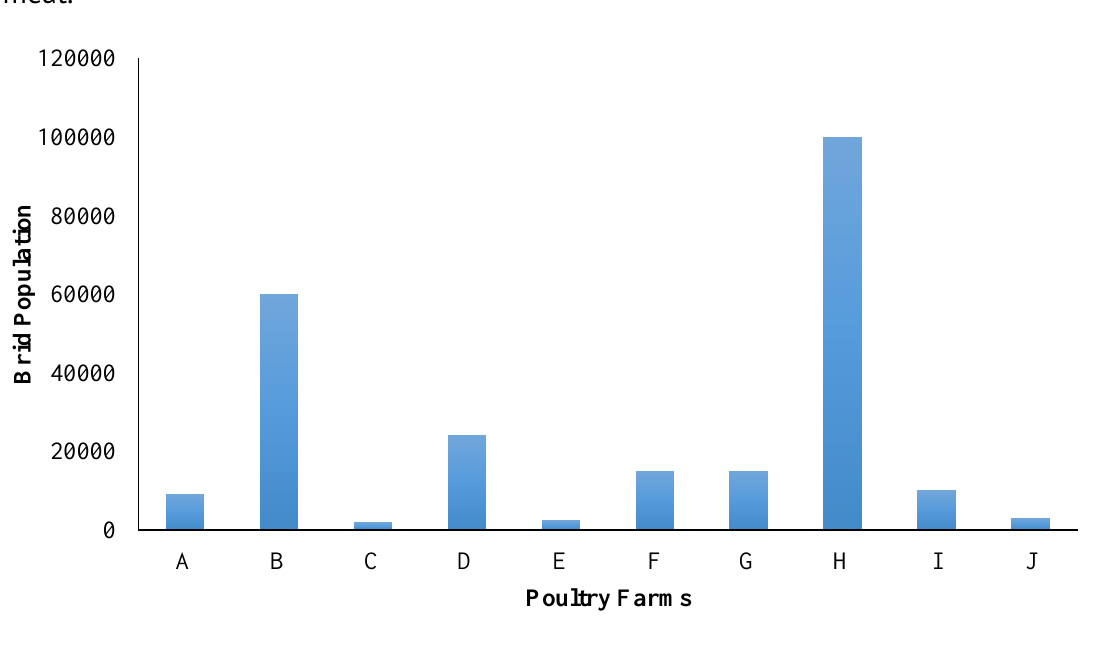
Figure 2. Bird population across various